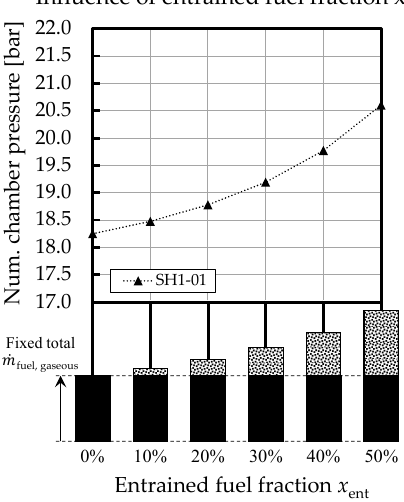
Figure 21. Impact of entrained fuel fraction x ent on P ch ,num for the simulation of SH1-01, while keeping the gaseous fuel mass flow rate constant.